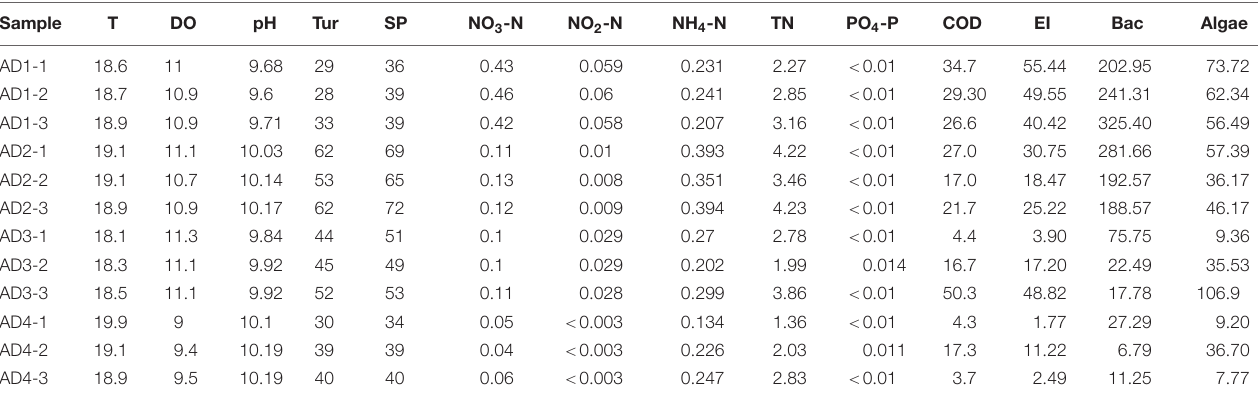
TABLE 1 | Environmental and biological properties of samples.